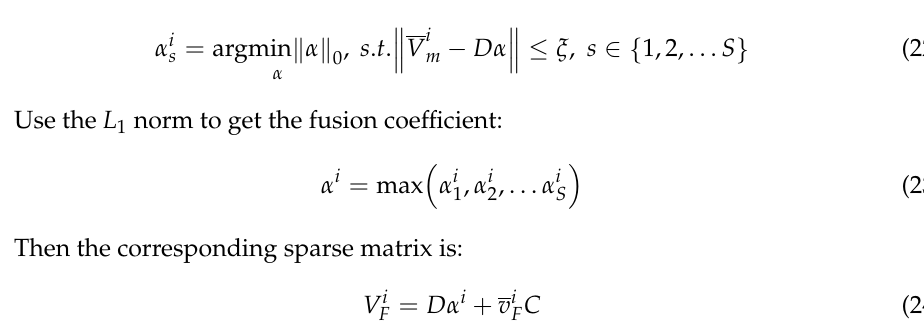
represents the mean of all m